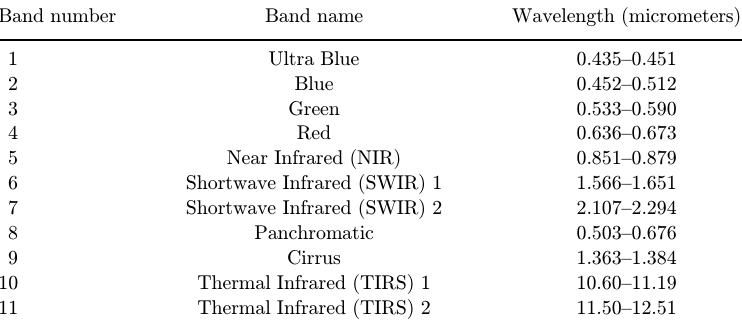
Table 2. Band names and respective wavelength ranges of Landsat-8 satellite